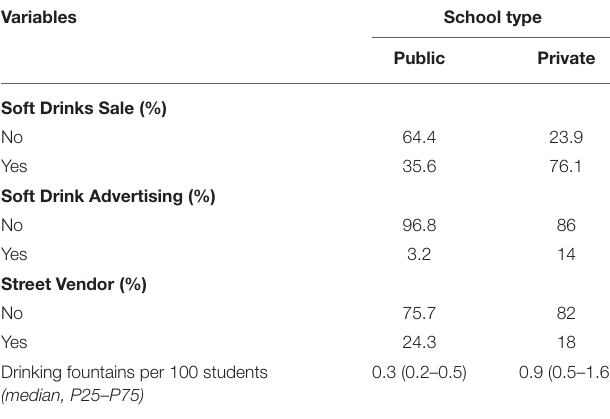
TABLE 2 | Characterization of Brazilian schools evaluated by the ERICA study, Brazil (2013–2014; n = 1,247).